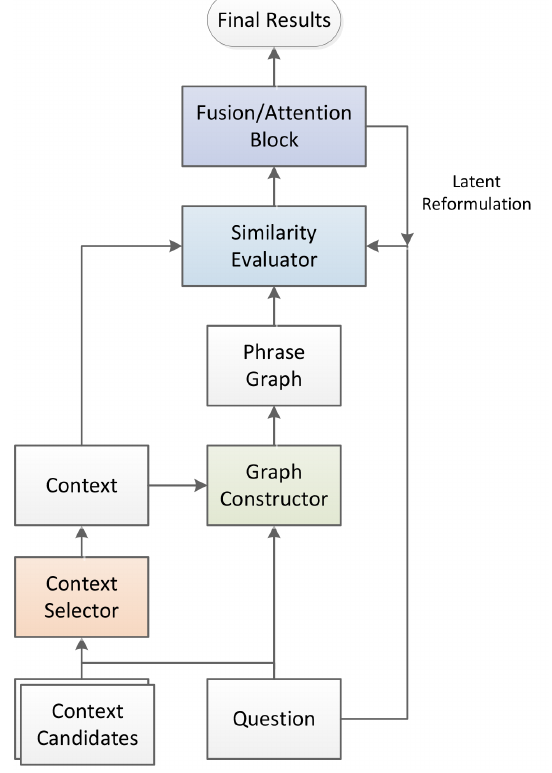
Figure 2. Framework of model